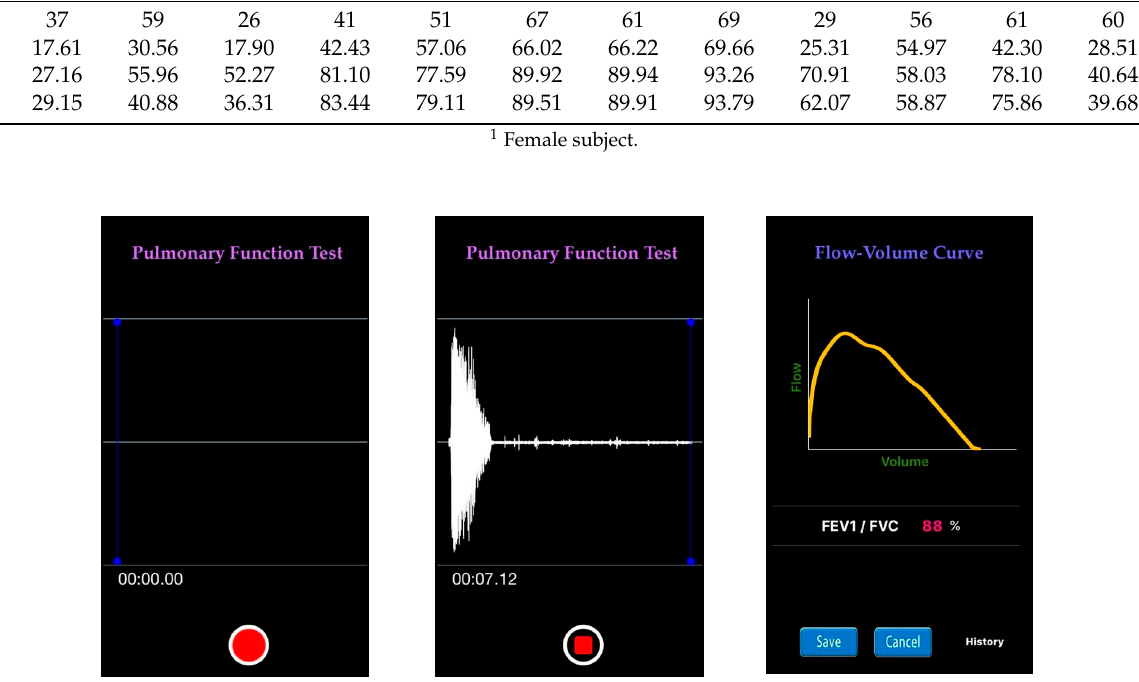
Figure 6. Snapshots of iPhone application for FEV 1 /FVC ratio estimation, developed using the Objective-C programming language: ( a ) before recording; ( b ) forced exhalation being recorded; and ( c ) flow-volume curve and estimated FEV 1 /FVC ratio displayed.